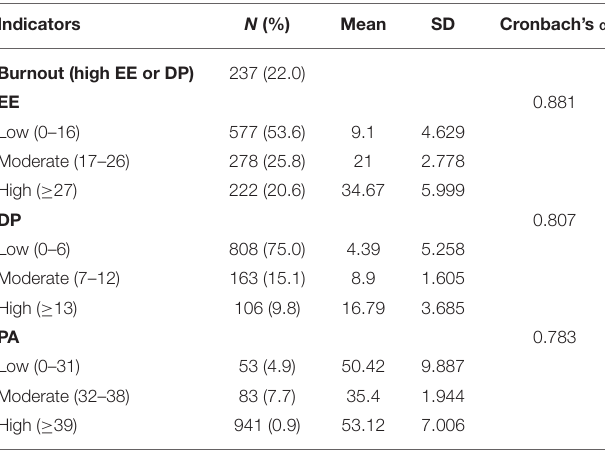
TABLE 2 | Distribution of the Maslach Burnout Inventory-Human Services Survey (MBI-HSS) subscale scores and the prevalence of burnout.